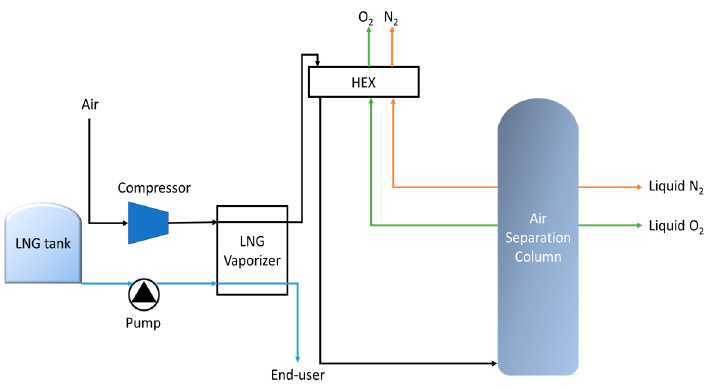
Figure 4. Air separation with LNG cold energy utilization [39].